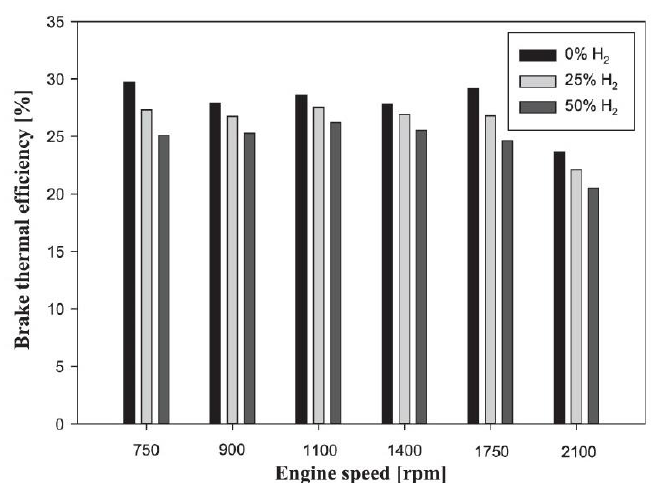
Figure 9. Brake thermal efficiency with different percentages of hydrogen in the CI engine [78].